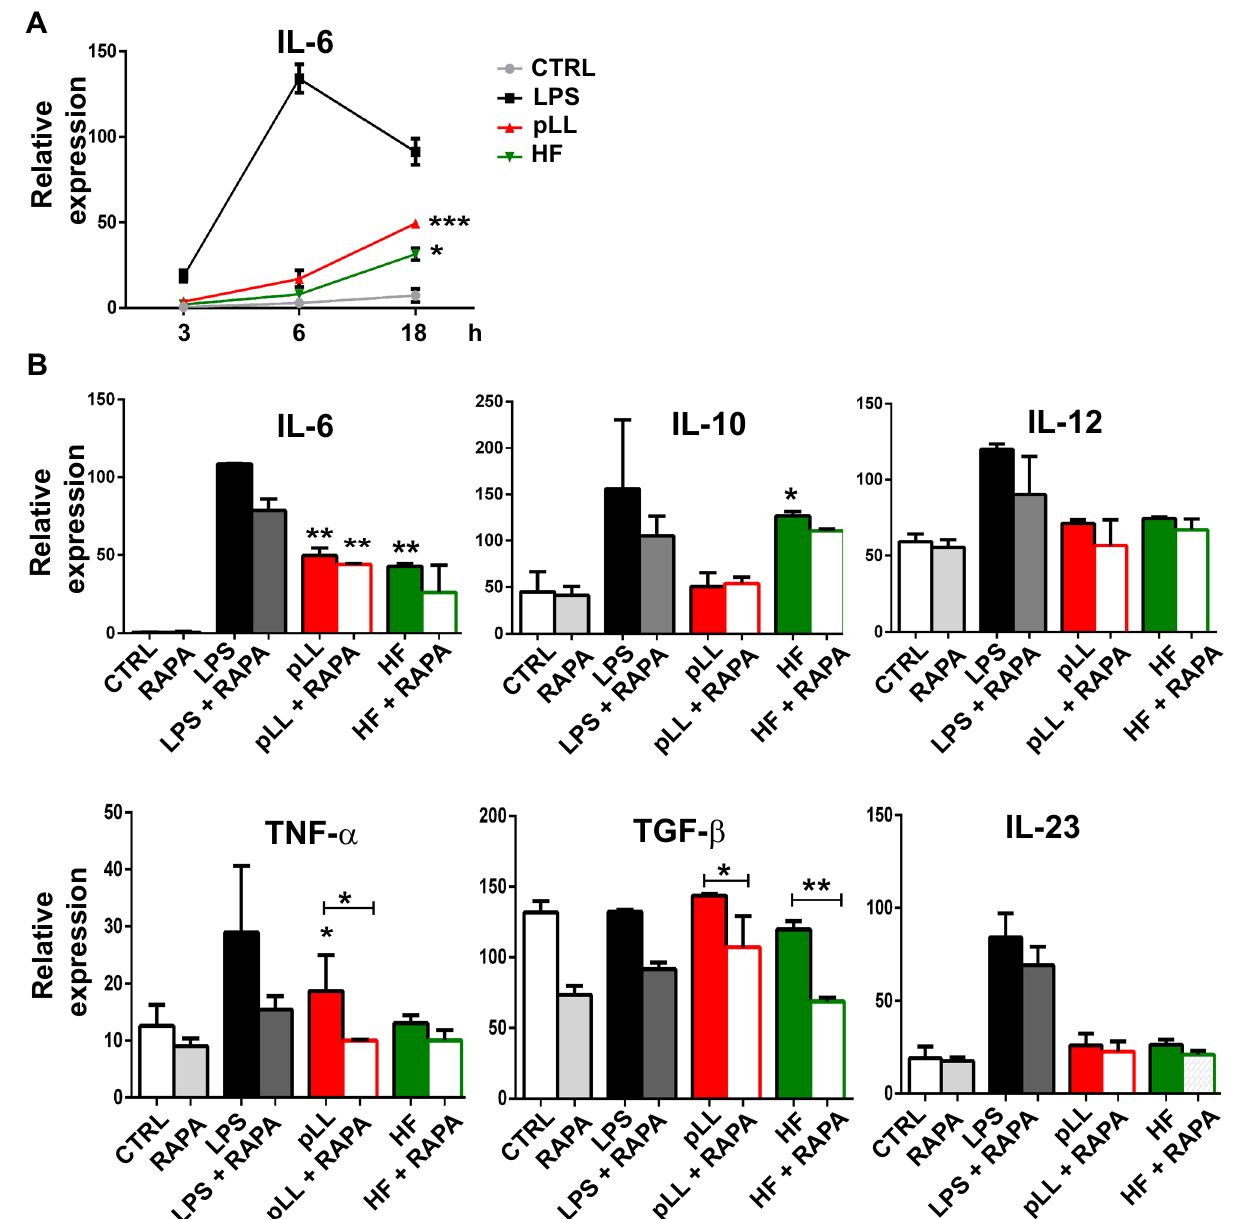
Figure 3. Purified laminar layer and hydatid fluid induce gene expression of pro- and anti-inflammatory cytokines by BMDCs. ( A ) BMDCs (1 × 10 6 /ml) were cultured alone (CTRL), with 100 ng/ml LPS, 20 μg pLL